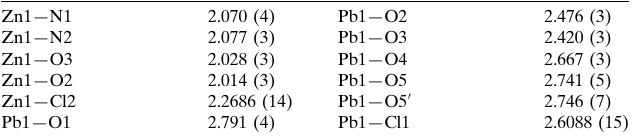
Selected bond lengths (A˚